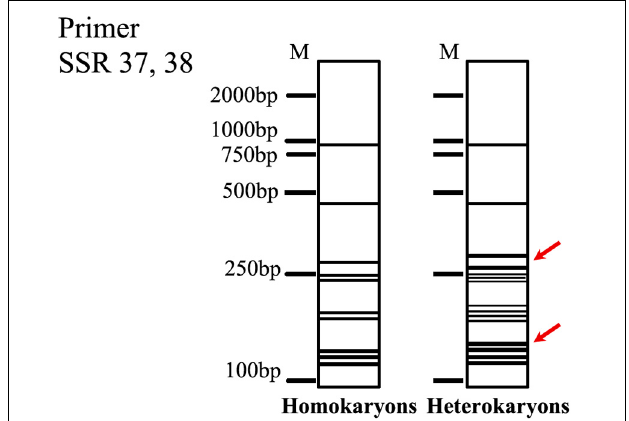
FIGURE 8 | The fingerprints of the homokaryon of W. cocos. The red arrow indicated the key